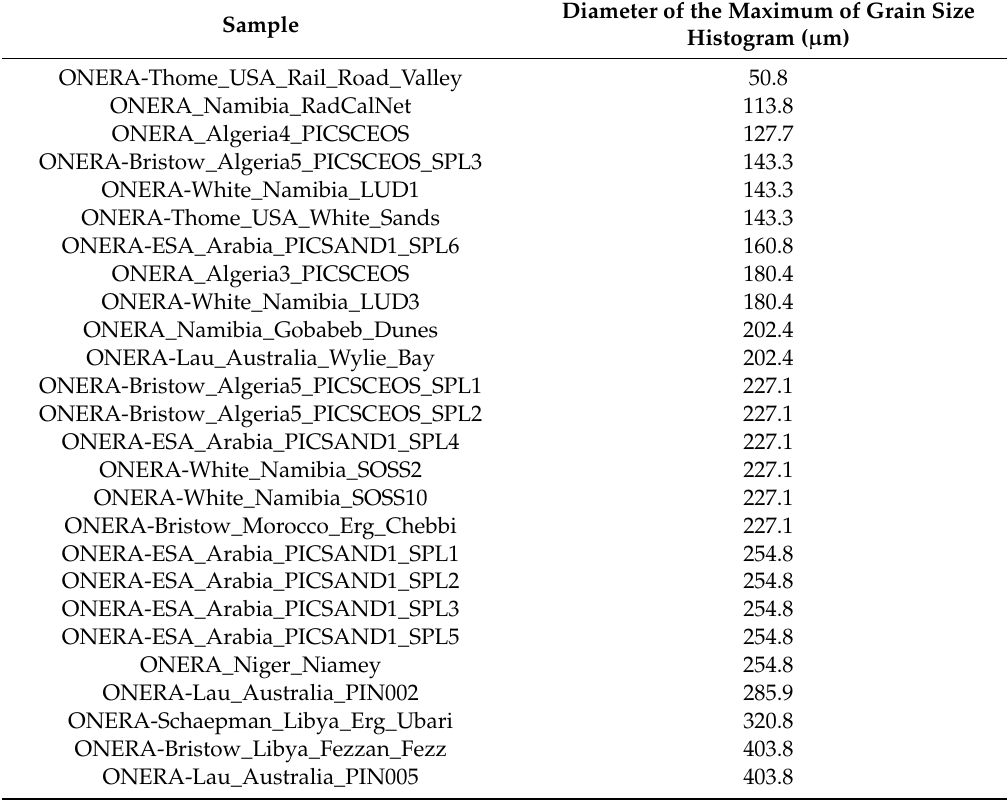
Table 5. Diameter corresponding to the maximum grain size distribution for the various samples.